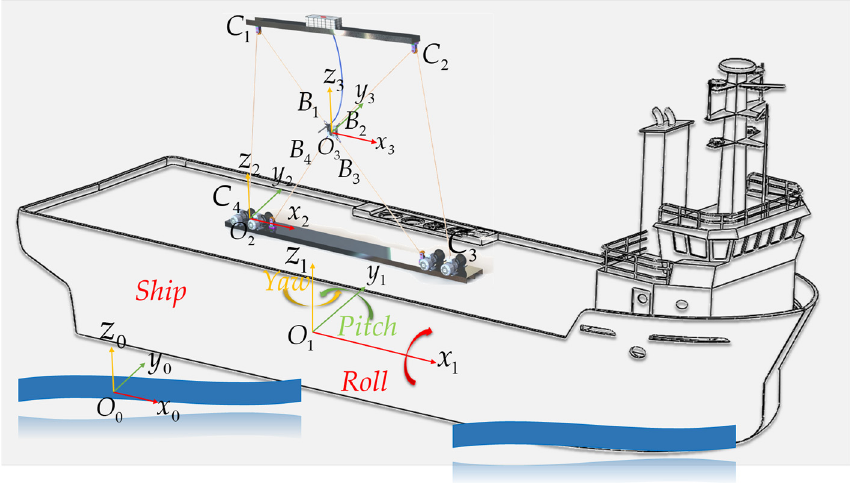
Figure 2. Reference frames of C ‐ DCR.